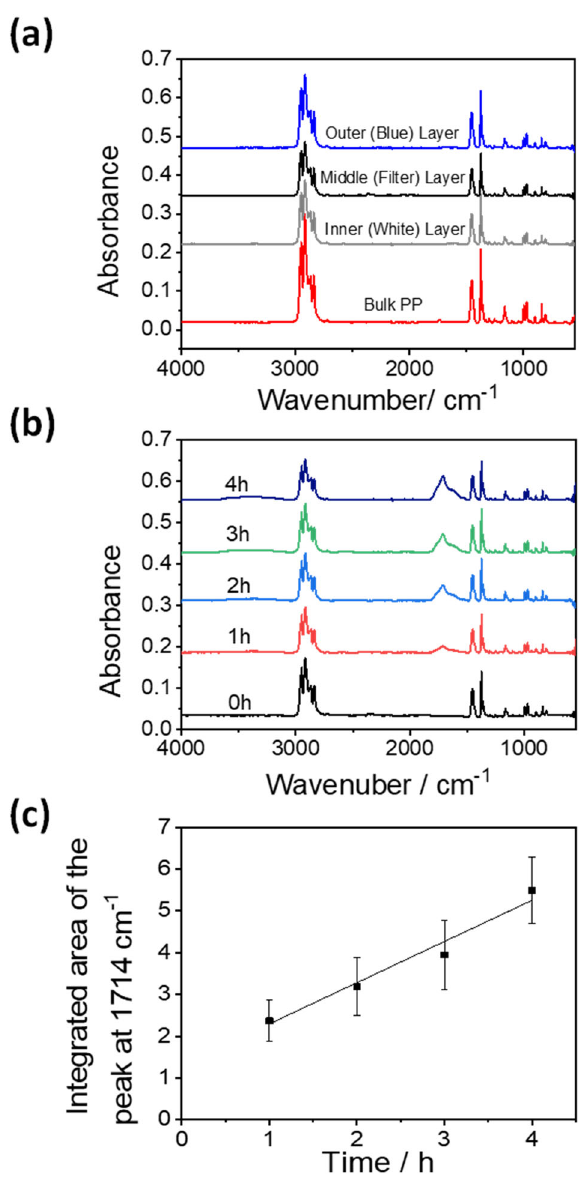
Fig. 5 FTIR analysis of mask degradation. a Typical ATR-IR spectra recorded for each layer of the three-ply face mask in comparison to that of standard bulk PP sample prior to plasma irradiation. This clearly identi fi es the mask material as PP. b ATR-IR spectra of a face mask sample as a function of irradiation time with 200 W of plasma. Note the appearance of the broad features centred around 1714 cm − 1 as the face mask material is etched with the plasma. c Integrated absorbance of the features at 1714 cm − 1 from the ATR- IR spectra of a face mask sample as a function of plasma irradiation time. The error bars represent the standard derivation of the data